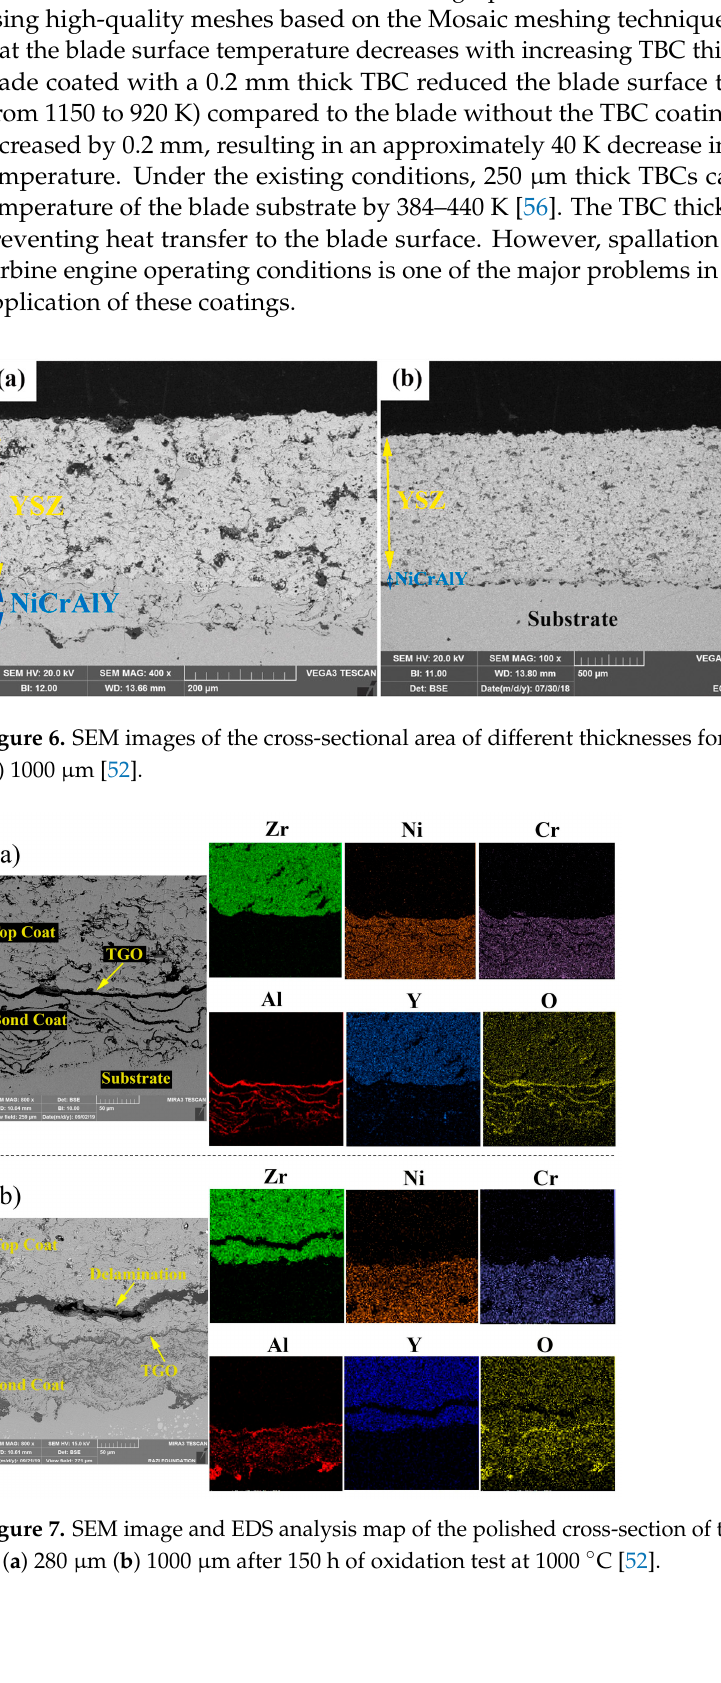
Figure 8. Effect of topcoat thickness on coating thermal insulation ( Δ T is the difference between the surface temperature of the uncoated substrate and the surface temperature of the substrate coated with the TBC), thermal shock lives (at 1000 ℃ ), and bonding strength. (adapted from [52] ).